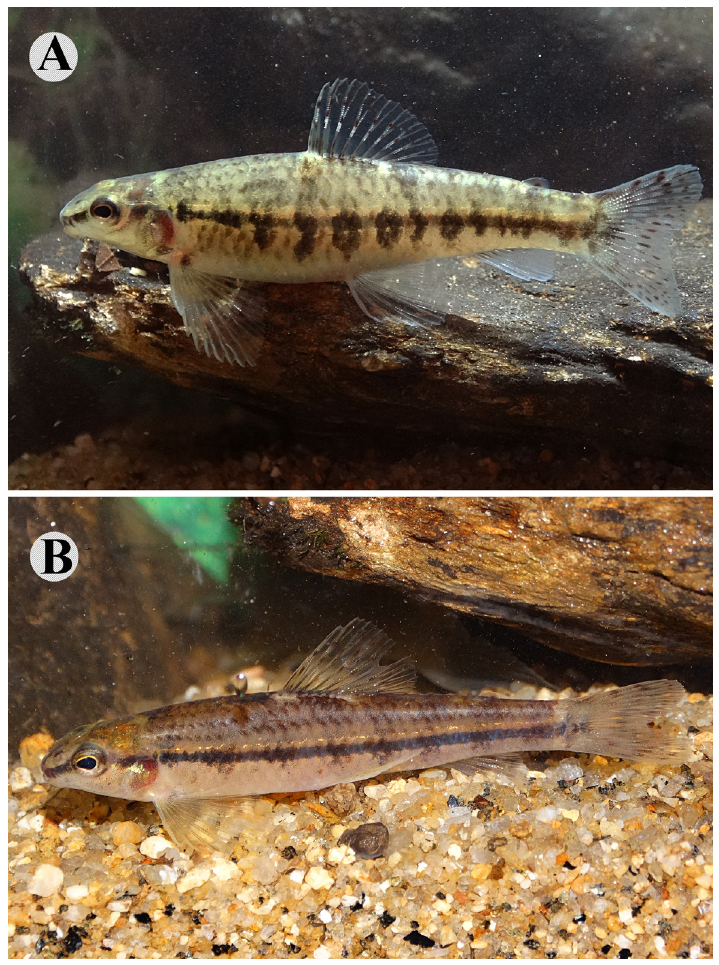
FIGURE 4 | Lateral views of uncatalogued aquarium specimens of Characidium krenak , showing the variable color patterns in life. A. Distinct black, rounded and vertically elongate blotches distributed along midlateral line of body. B. Inconspicuous blotches on midlateral line of body. All from